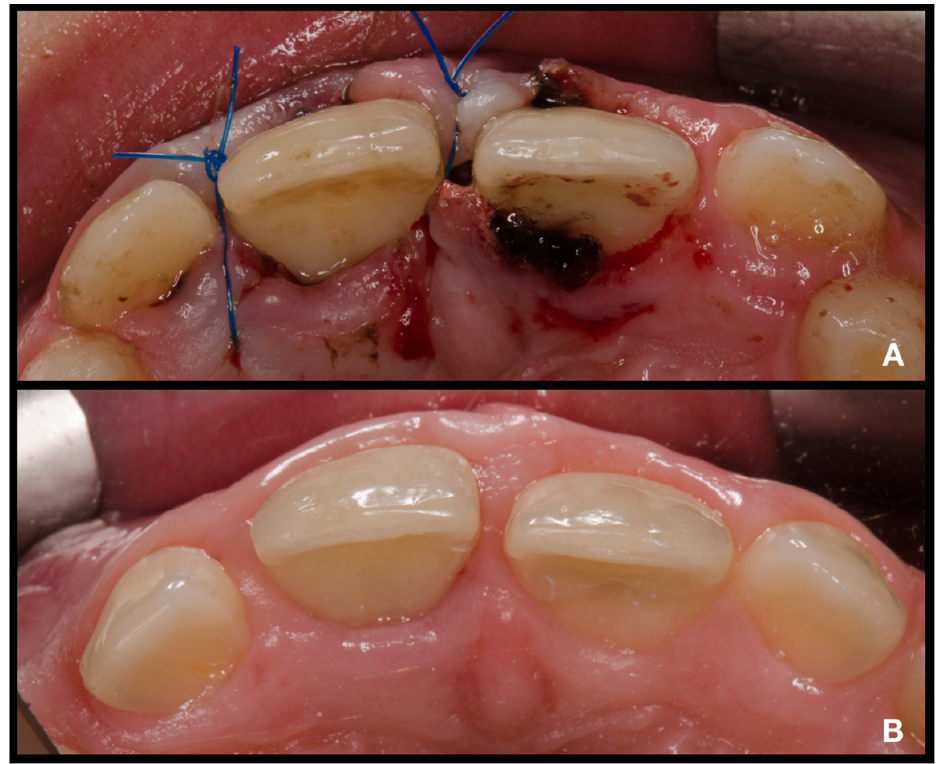
Figure 8. Intraoral photographs of teeth 12–22 from occlusal view. ( A )—immediately after treatment; ( B )—24-month follow-up.